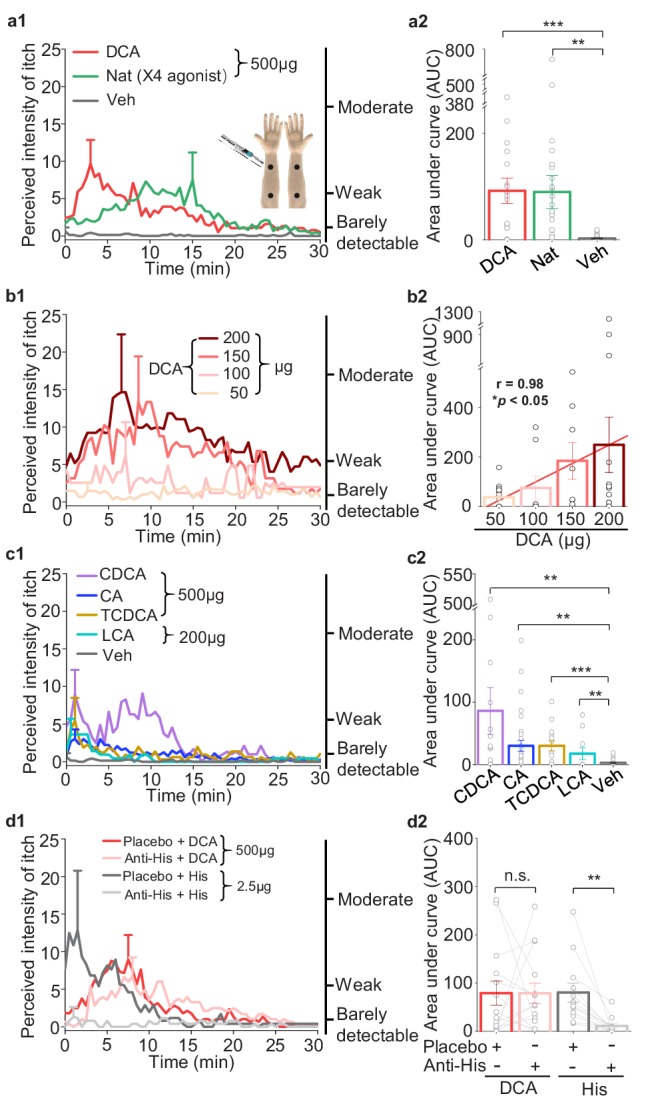
Bile acids and MRGPRX4 specific agonist induce histamine-independent itch in human.(a1–a2) Itch evoked by a double-blind intradermal injection of DCA and nateglinide (Nat) in human subjects. (25 μl for each injection) (a1) Time courses of the perceived itch intensity (n = 18–32). The traces are plotted with the standard error of the mean (s.e.m.) at the peak of each trace. The descriptions of the itch intensity are shown on the right. The injection sites on the subject’s forearm are indicated (inset). X4, MRGPRX4 (a2) Summary of the area-under-curve (AUC) of the itch intensity traces shown in (a1). (b1–b2) Itch evoked by the indicated doses of DCA (25 μl for each injection, n = 8–14). The linear regression analysis of concentration versus the AUC is showed as a red line. (c1–c2) Itch evoked by CDCA, CA, TCDCA, and LCA (25 μl for each injection, n = 10–31). The vehicle data (Veh) is reproduced from (a1). (d1–d2) DCA-evoked itch is not inhibited by antihistamine (Anti-His). (d1) Time course of itch intensity evoked by an intradermal injection of DCA or histamine (His) following antihistamine or placebo pretreatment (25 μl for each injection, n = 12–14). Each pair of dots connected by a gray line represents an individual subject. All error bars represent the s.e.m.. Student’s t-test, *p<0.05, **p<0.01, ***p<0.001, and n.s. not significant (p>0.05).